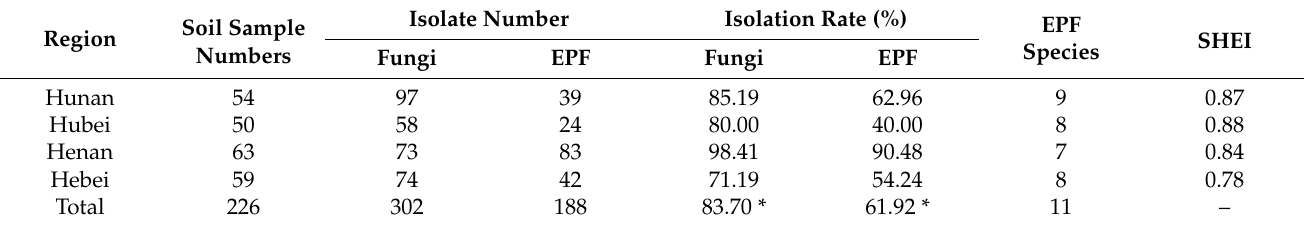
Table 2. The fungi isolation and biodiversity of different regions.